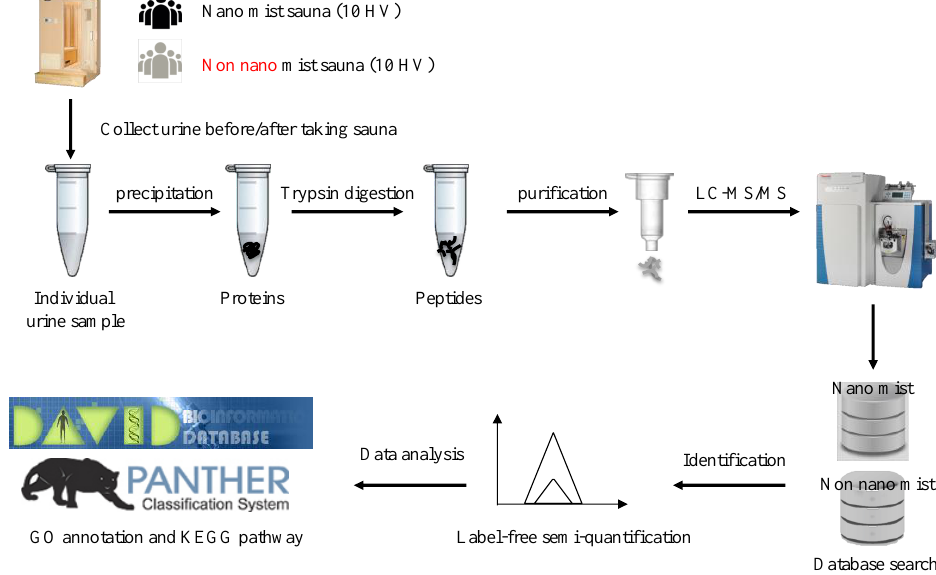
Figure 2. Schematic illustration of the urine proteomic screening process.